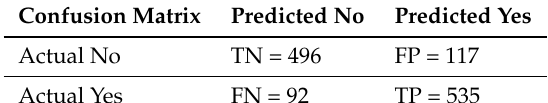
Figure 7. Performance comparison of parameter tuning. Table 9. Confusion matrix values of the proposed model. TN: true negative; FP: false positive; FN: false negative; TP: true positive.